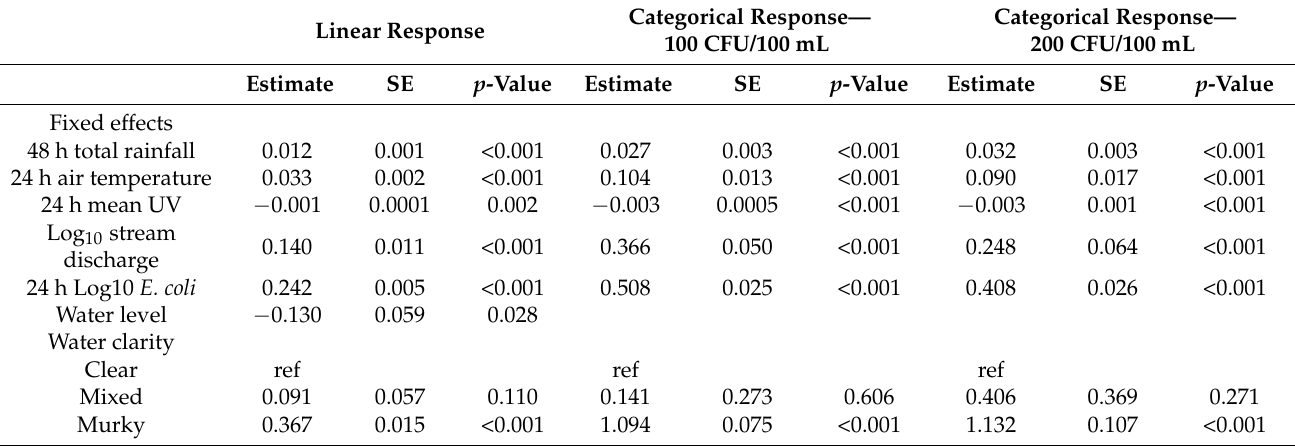
Table 3. Toronto Linear Mixed Effects and Logistical Mixed Effects